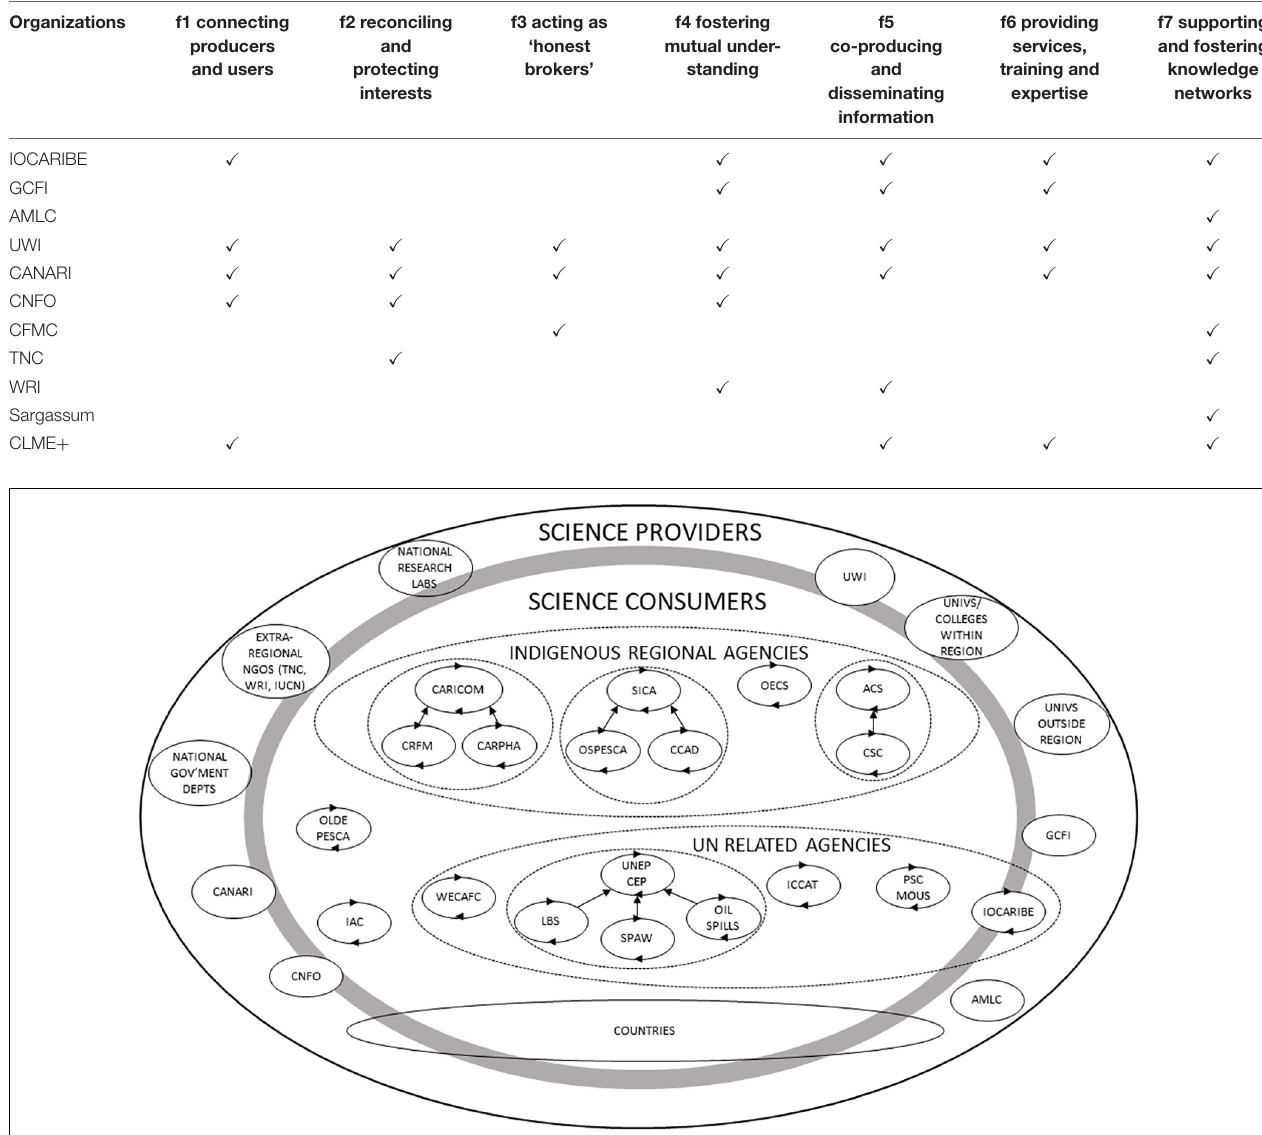
TABLE 2 | Preliminary assessment of organizations within the WCR demonstrating the boundary-spanning functions of Goodrich et al. (2020). Organizations